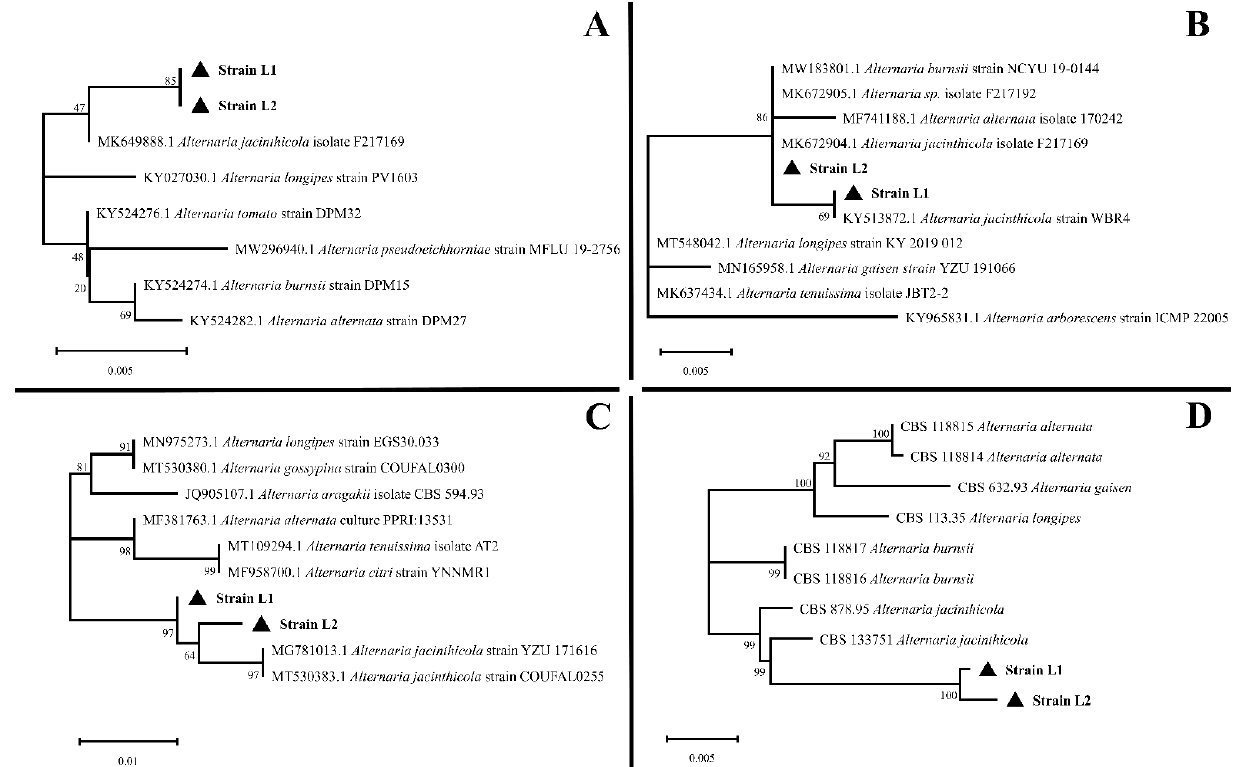
Figure 2. Phylogenetic trees constructed using GAPDH , TEF , Alt a1 , and tandemly linked ITS , GAPDH , TEF , and Alt a1 sequences from Alternaria species. ( A ) Phylogenetic tree constructed using GAPDH gene sequences from different Alternaria species. ( B ) Phylogenetic tree constructed using TEF gene sequences from different Alternaria species. ( C ) Phylogenetic tree constructed using Alt a1 gene sequences from different Alternaria species. ( D ) Phylogenetic tree constructed using tandemly linked ITS , GAPDH , TEF , and Alt a1 sequences from different Alternaria species. The numbers at the nodes indicate the bootstrap values calculated for 1000 repetitions. The isolated strain L1 and strain L2 is shown in bold and triangle.